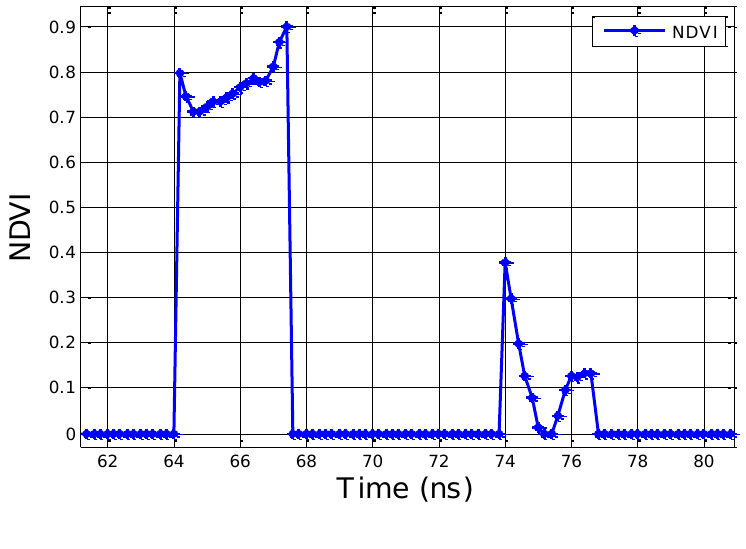
Figure 5. The NDVI of the echoes of the two-channel hyperspectral LiDAR for two targets (Spectralon panel behind the Norway spruce tree, cf. Figure 4), averaged for 16 measurements and the echoes after